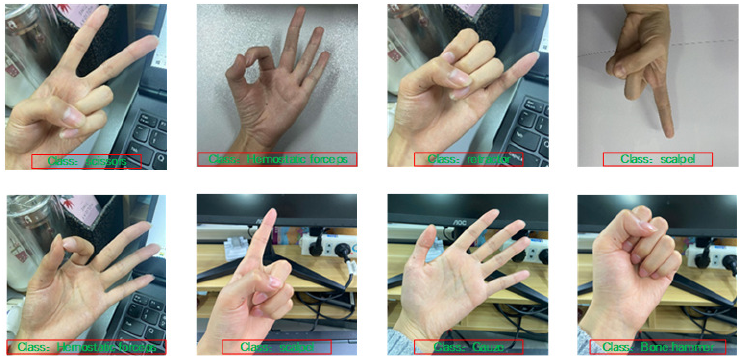
Figure 13. Result of the part of the